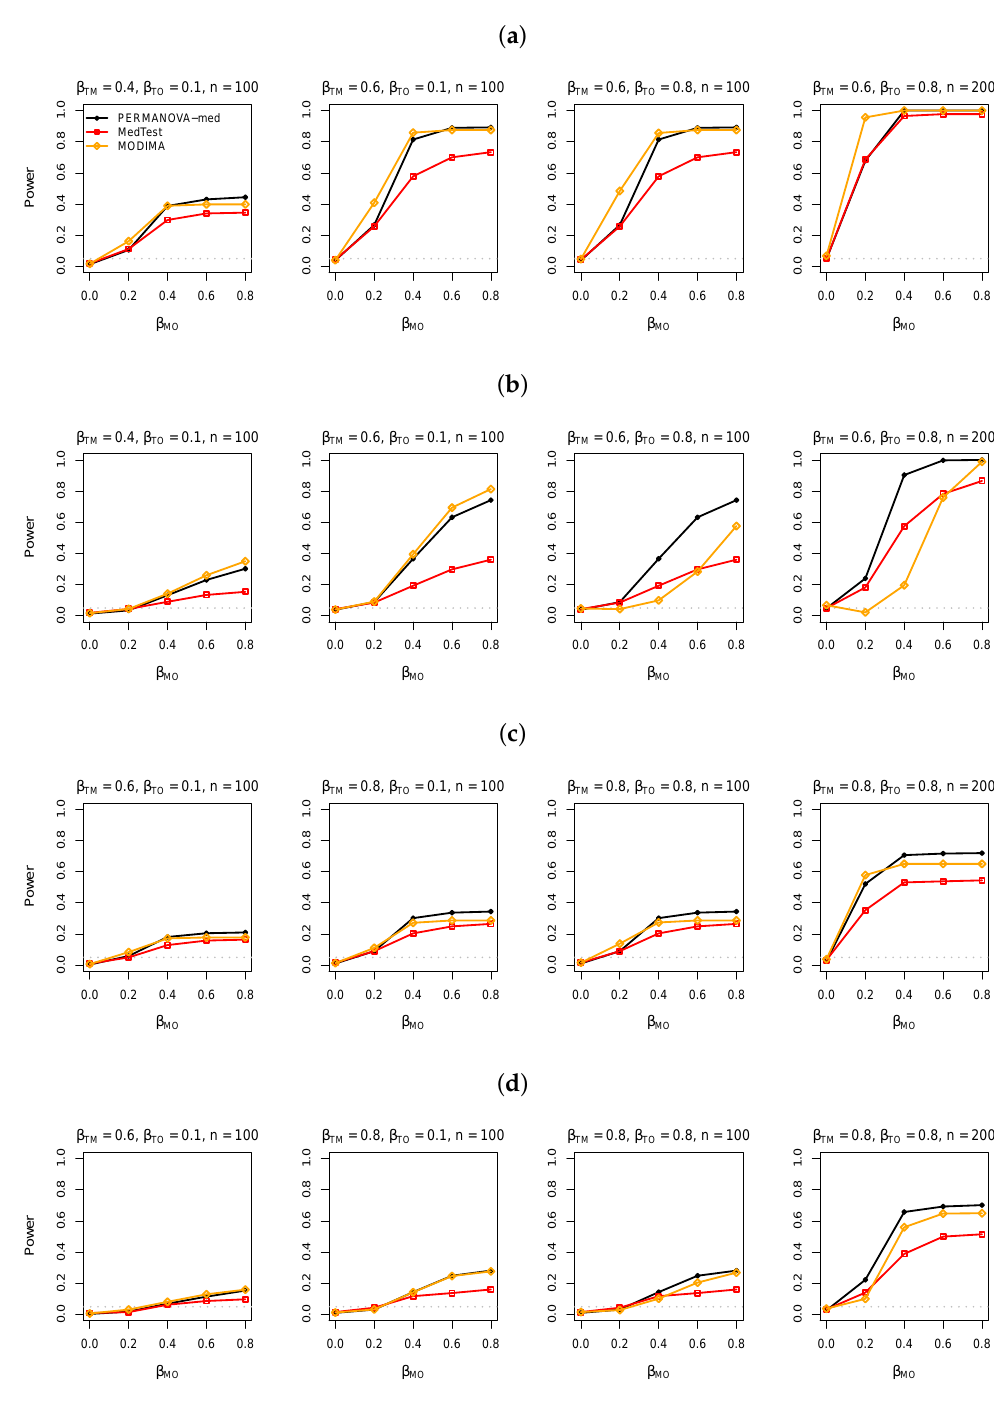
Figure 4. Simulation results in analysis of simulated data under M-mixed. ( a ) Binary exposure, taxa 4, 5, 51, and 52 for the M-O association. ( b ) Binary exposure, taxa 51 and 52 for the M-O association. ( c ) Continuous exposure, taxa 4, 5, 51, and 52 for the M-O association. ( d ) Continuous exposure, taxa 51 and 52 for the M-O